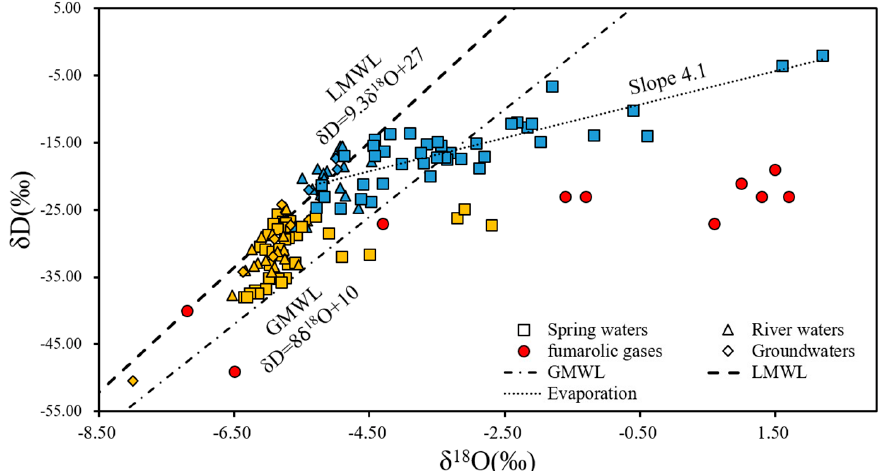
Figure 8. Relationship between δ D and δ 18 O of groundwater, stream water, and hot spring water in the TVG. The blue and yellow data points indicate the samples in the north and south areas of the TVG, respectively.